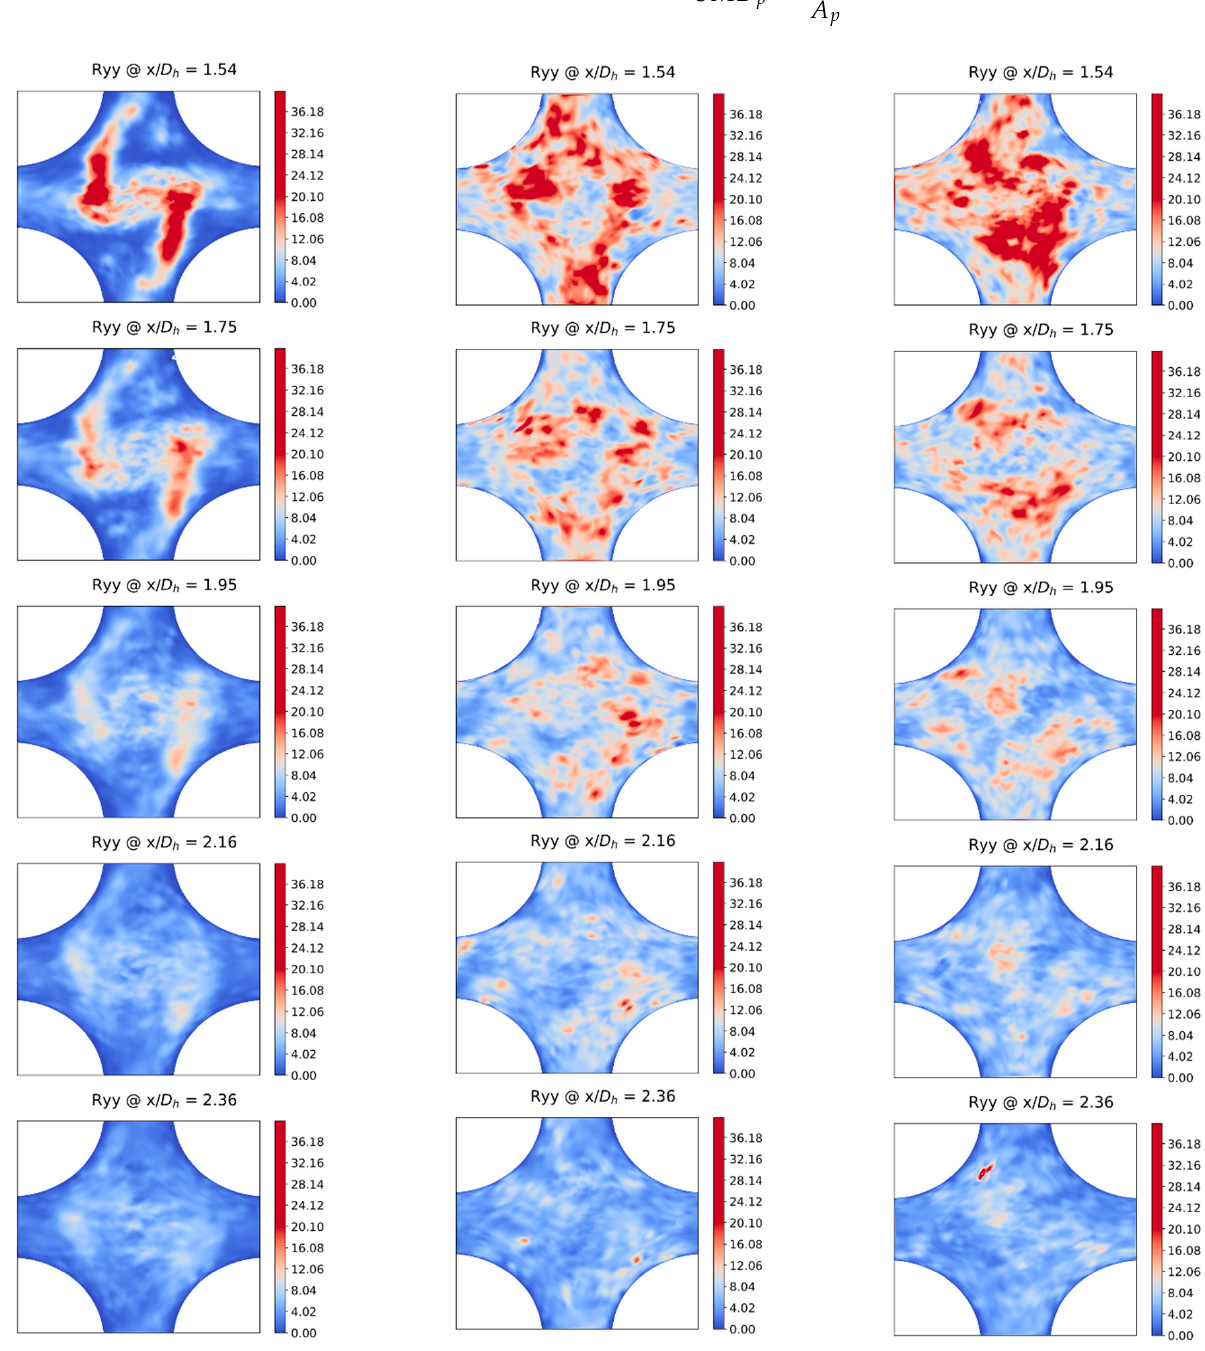
Figure 13. Axial evolution of downstream normalized lateral ( 𝒚 ) component of Reynolds stress for the single-phase ( left ), We40 ( middle ) and We80 ( right ) cases.